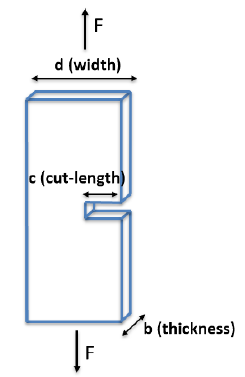
Figure 1. The geometry of the Mode I test specimen [12].